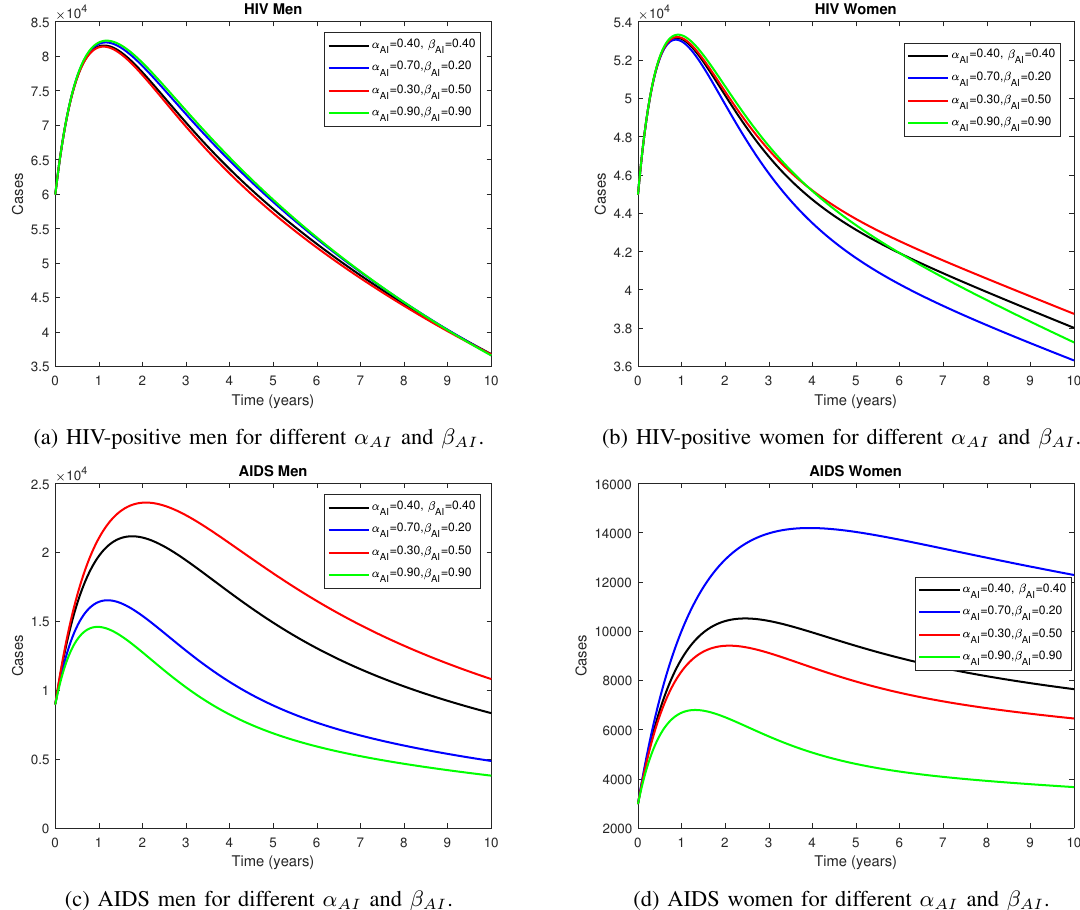
(c) AIDS men for different α AI and β AI . (d) AIDS women for different α AI and β AI . Fig. 14: Behavior of HIV, AIDS and undetectable for the joint variations of α AI and β AI